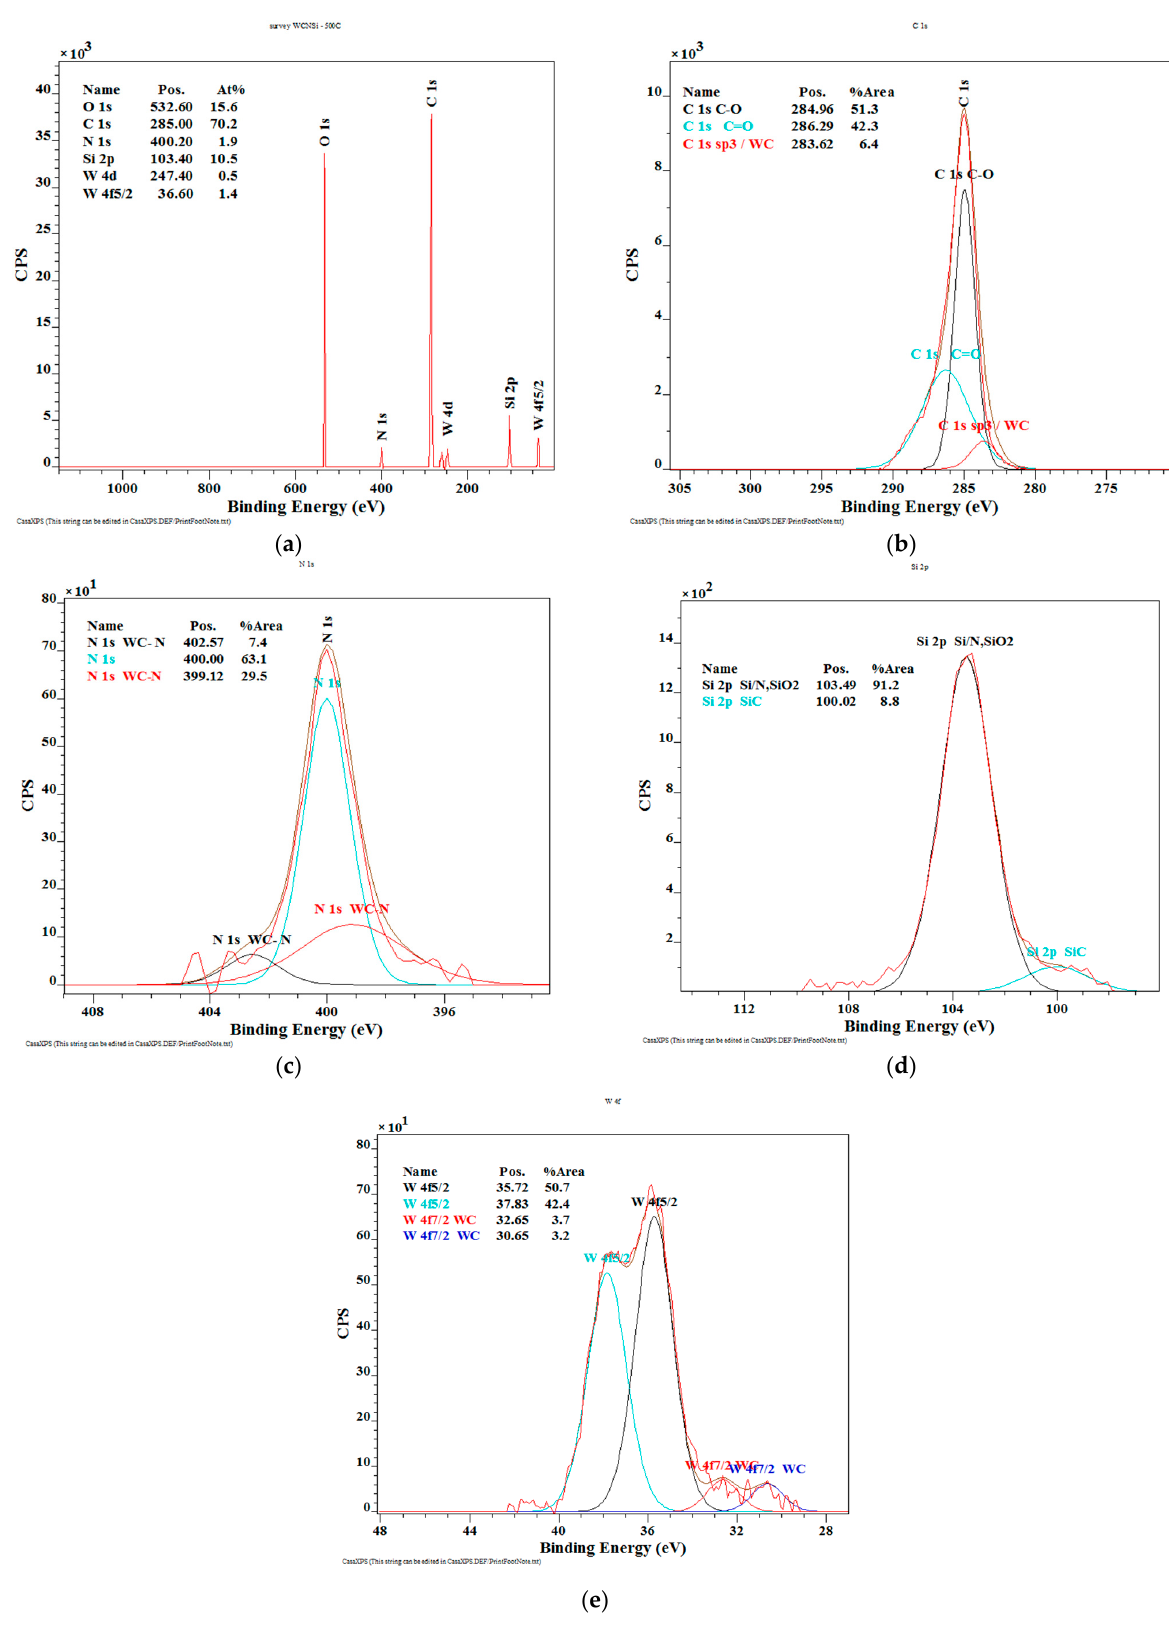
Figure 5. The XPS surface results of the WC/C coating annealed at 500 °C (at.%): ( a ) chemical composition; ( b ) chemical bonds C; ( c ) chemical bonds N; ( d ) chemical bonds Si; ( e ) chemical bonds W.